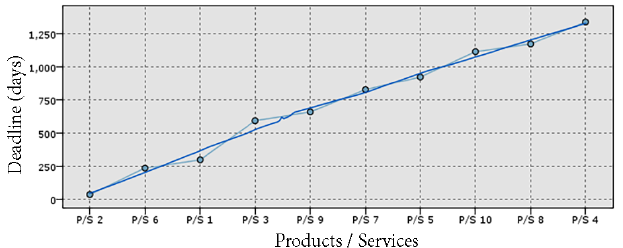
Figure 7. Order of launch of each project PS i according to its importance level